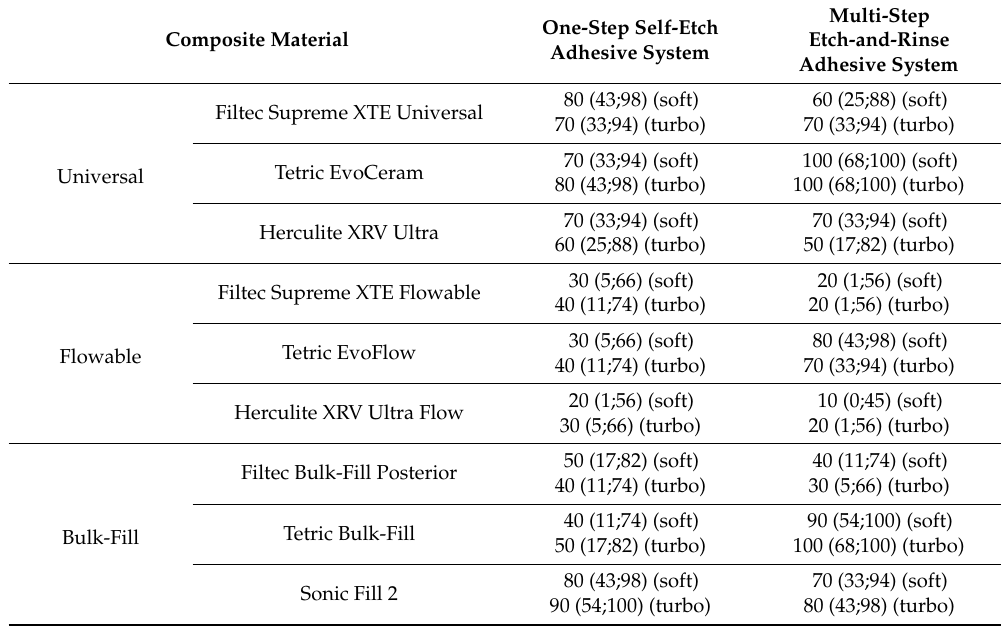
Table 2. Relative frequencies with 95% confidence intervals [%(95%CI)] of adhesive fracture types for each tested group